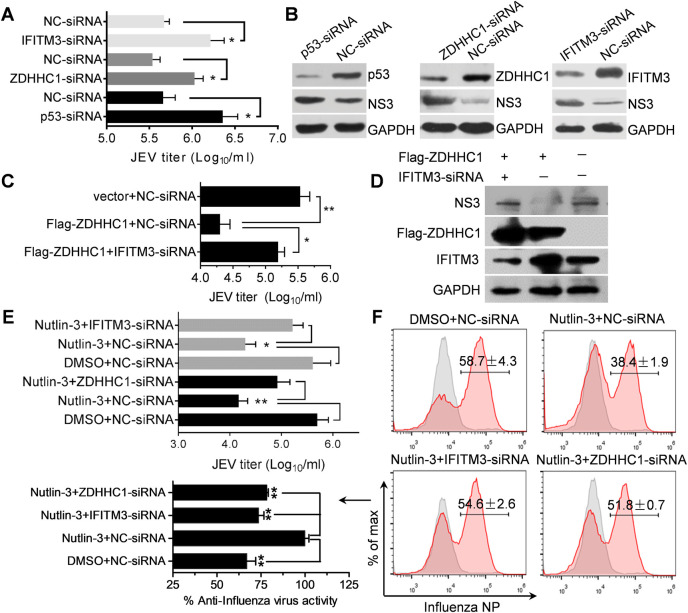
Anti-JEV activity of the p53-ZDHHC1-IFITM3 pathway.(A and B) A549 cells were treated with p53-siRNA, ZDHHC1-siRNA, IFITM3-siRNA, or control NC-siRNA for 72 h and then infected with JEV at 1 MOI for 24 h, JEV titres in the supernatants were measured by TCID50 assay (A), viral NS3 protein expression was detected by western blot (B). (C and D) A549 cells were transfected with IFITM3-siRNA for 48 h and subsequent Flag-ZDHHC1 for 24 h, then followed by infection with JEV at 1 MOI for 24 h, JEV titres and NS3 expression were detected as above. (E) A549 cells were treated with ZDHHC1-siRNA or IFITM3-siRNA for 48 h, followed by Nutlin-3 for 24 h, and infected with JEV at 1 MOI for 24 h. JEV titres in the supernatants were measured by TCID50 assay. (F) A549 cells were transfected with ZDHHC1-siRNA or IFITM3-siRNA for 48 h and subsequent Nutlin-3 for 24 h, then followed by infection with IAV at 1 MOI for 24 h, viral NP protein expression was measured with flow cytometry and anti-IAV activity was compared with Nutlin-3 treatment (set as 100). Unpaired t test, *P<0.05; **P<0.01.